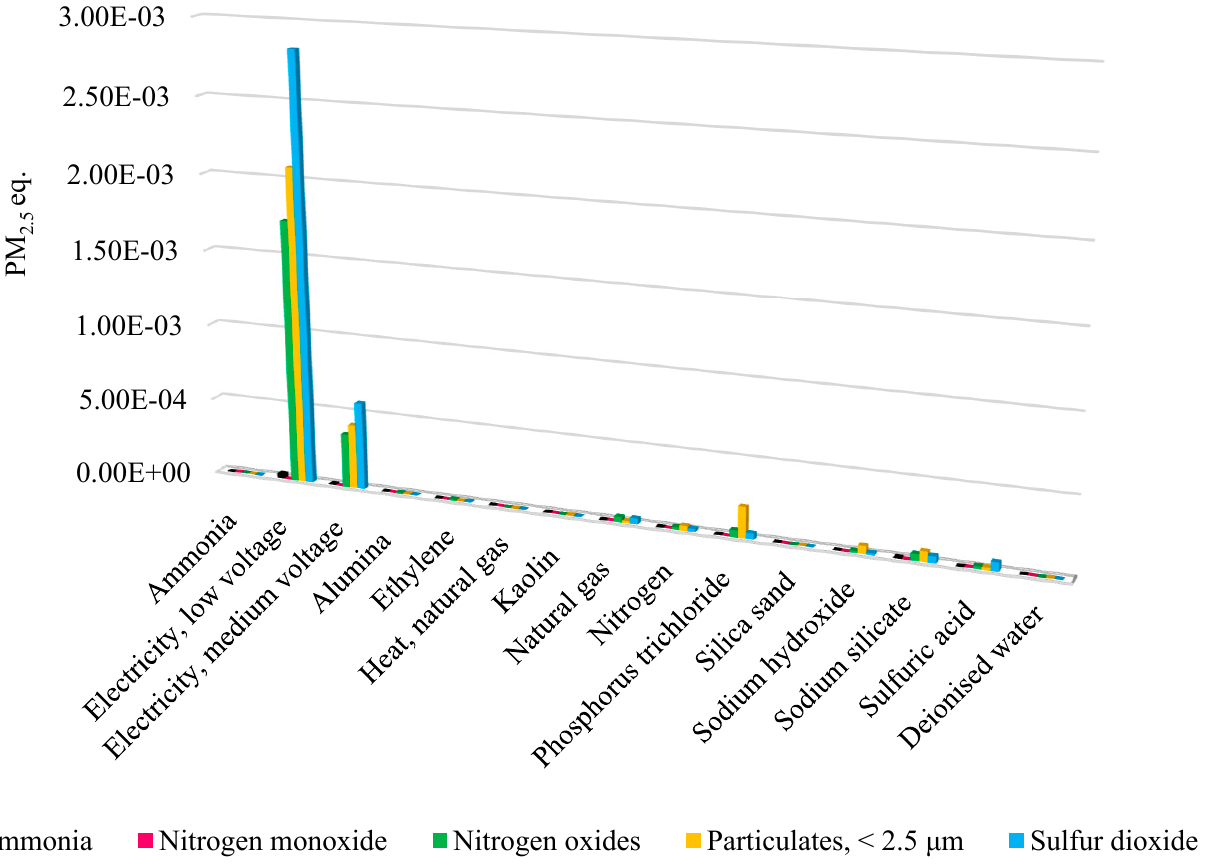
Figure 5. Inputs contribution to inorganic emissions of pyrolysis with ZSM-5 catalyst. Terrestrial ecotoxicity